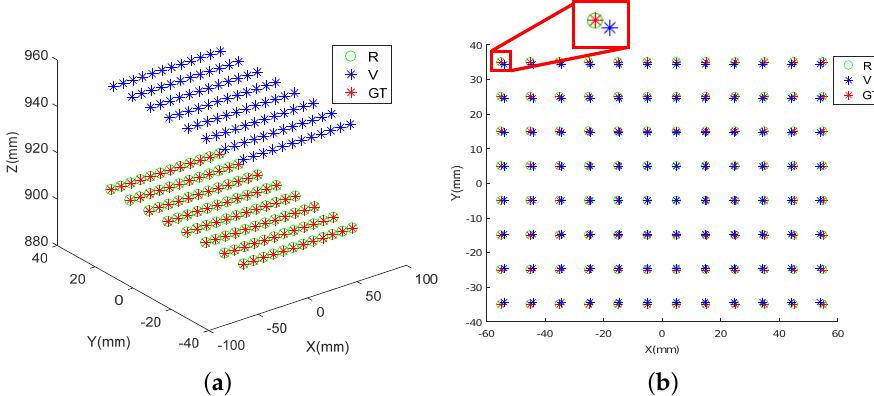
Figure 7. Reconstructed results of simulated experiment. ( a ) Side view of reconstructed results. ( b ) Top view of reconstructed results. R represents results using plenoptic disc radius. V indicates the results utilizing concept of virtual depth. GT stands for ground truth.